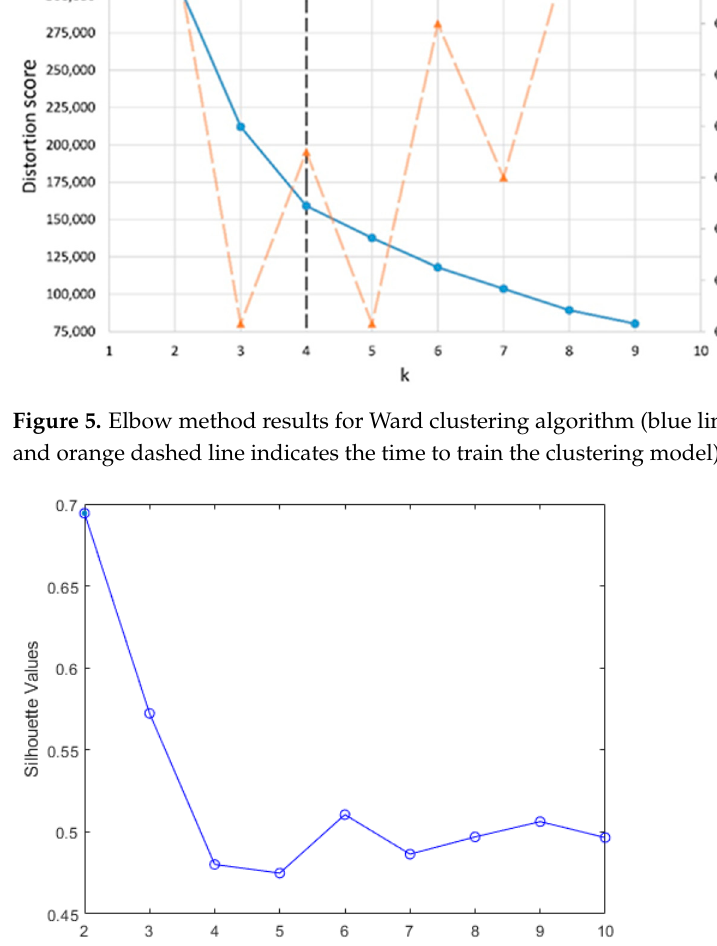
Figure 6. Silhouette score results for K-means clustering algorithm.